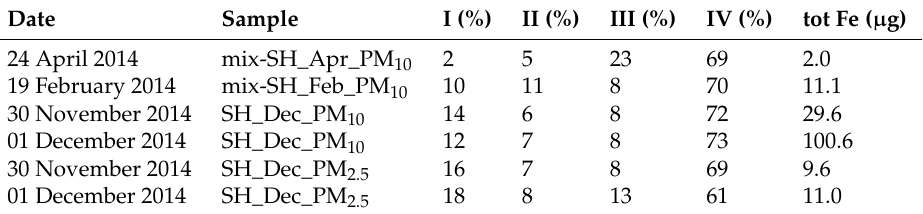
Table 4. Leaching test results after blank